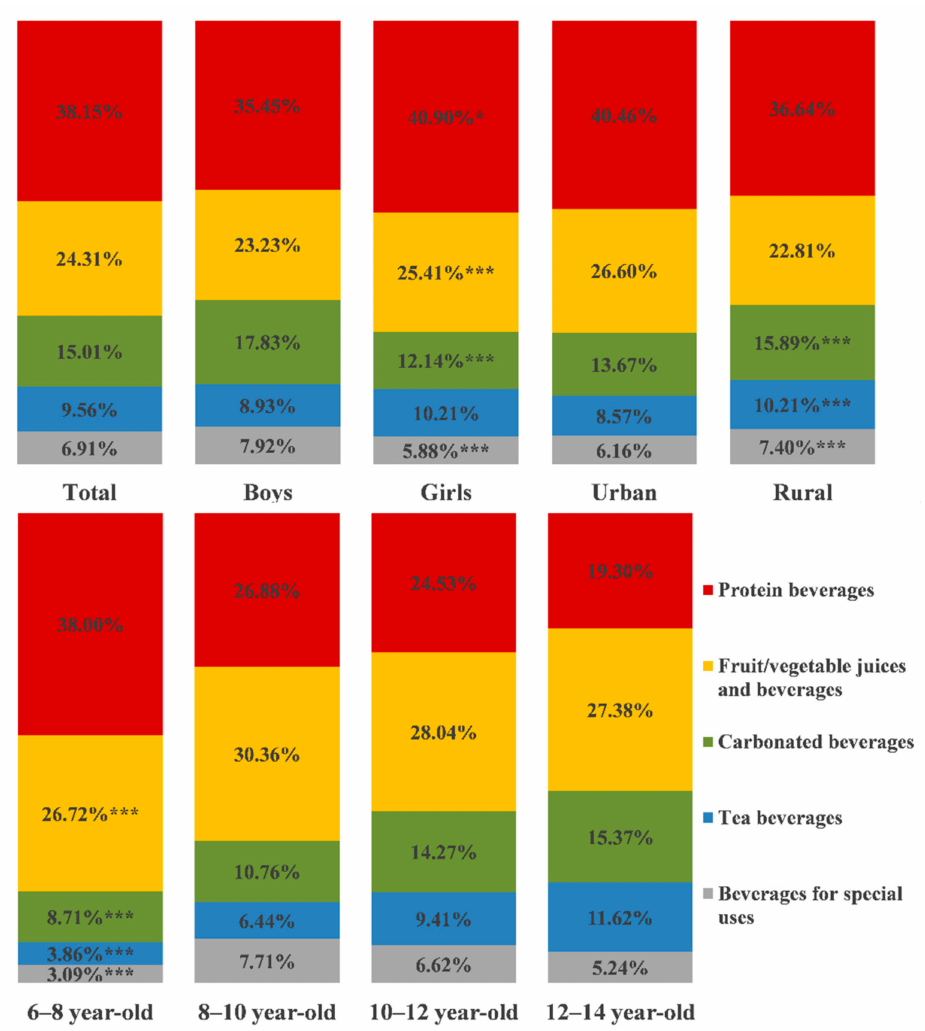
Figure 1. Proportions of sugar intake from each kind of beverage in total sugar intake from beverages. Sources of sugar intake from each beverage by gender, age and residence (the proportion of total sugar intake from beverages, %). * p < 0.5, *** p < 0.001. Compared with by Mann–Whitney U test and Kruskal–Wallis test in non-parametric test. Detailed differences between groups are shown